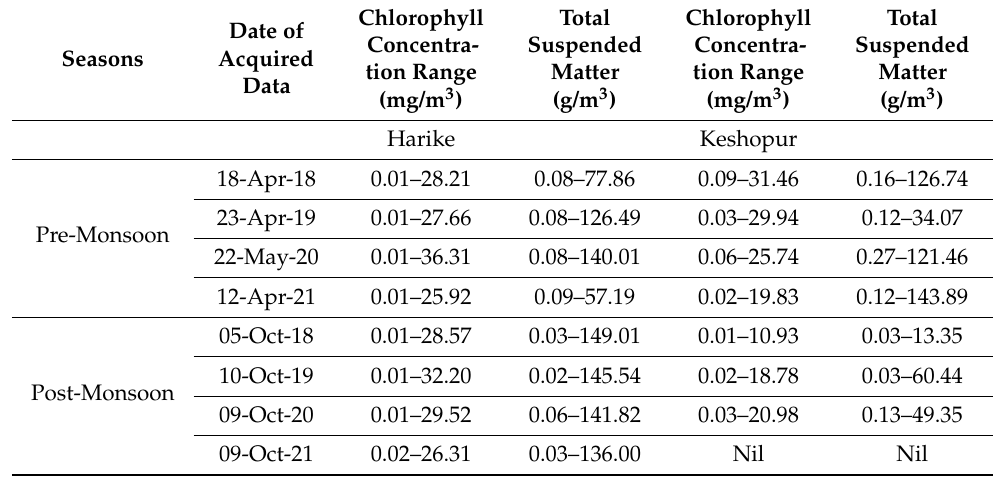
Figure 5. Spatial and temporal variations of chlorophyll concentration ( left side) and total suspended matter ( right side) over Keshopur during Pre- and Post-monsoon season from 2018 to 2021. Table 1. Chlorophyll and total suspended matter range derived from Sentinel-2 satellite data during both seasons (Pre- and Post-monsoon) over Harike and Keshopur